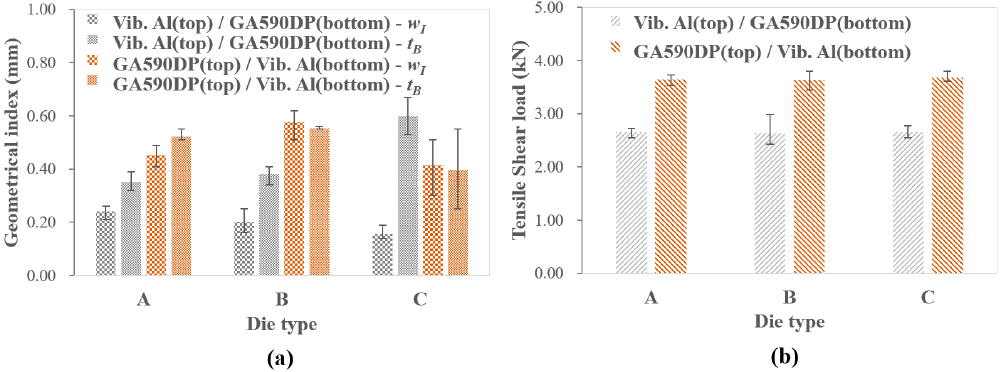
Figure 10. ( a ) The interlock width and the bottom thickness, and ( b ) the tensile shear loads of the self- piercing riveted joint formed between vibration-damping Al and GA590DP with respect to the die type and the panel configuration.